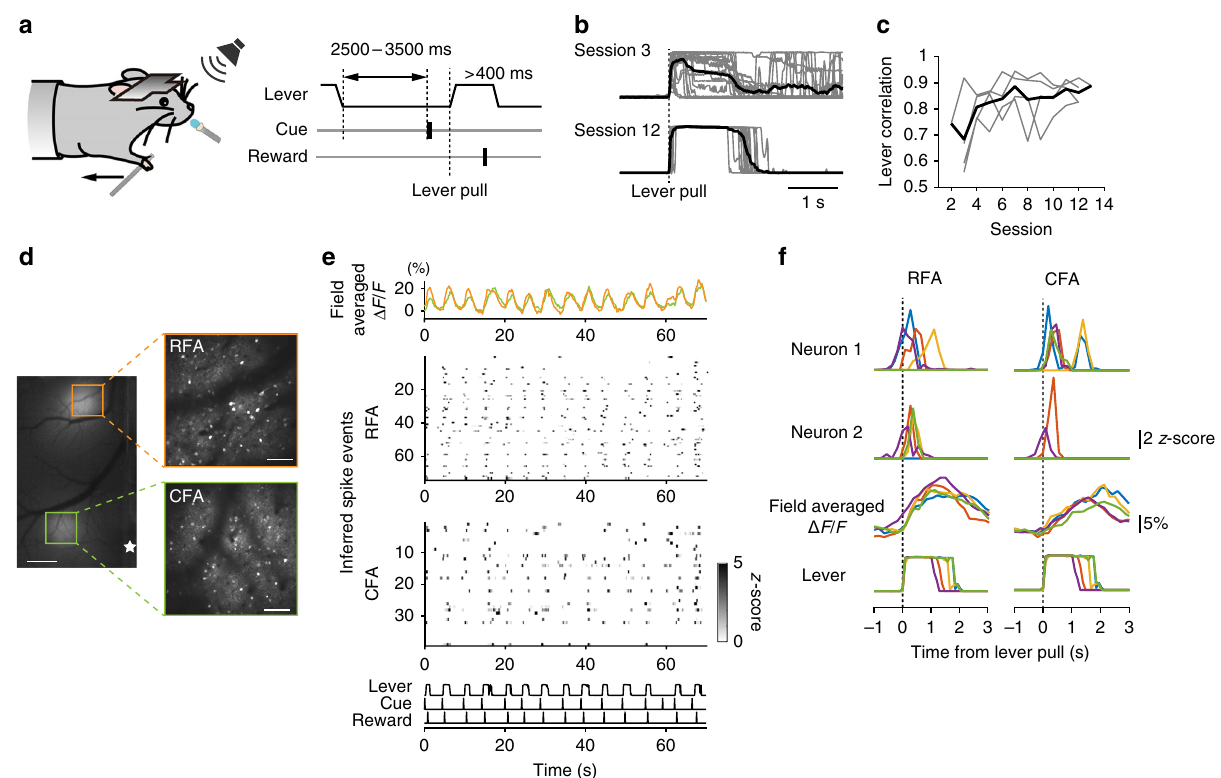
Fig. 7 Dual- fi eld imaging of the RFA and CFA during performance of a forelimb-movement task. a Schema of the sound-cued lever-pull task. To obtain a drop of water, the mouse needed to use its right forelimb to pull the lever 5 mm for a duration of 400 ms after presentation of a tone. b Example lever trajectories from sessions 3 and 12. Lever trajectories were aligned to the lever-pull onset. The fi rst 20 trials of each session are shown. Gray lines indicate individual trials and black lines are the means. c Improvement in lever correlation during the task sessions. The sessions in which the mice performed a simpler task to associate the cue signal and licking (session 1 for one mouse and sessions 1 and 2 for three mice) were not plotted. d Left, an epi fl uorescence image of GCaMP6s-expressing neocortex. Orange (RFA) and green (CFA) squares indicate imaging fi elds of the dual- fi eld two-photon imaging. The white star indicates the bregma. Scale bar, 500 µ m. Right, averaged two-photon images of layer 2/3 neuronal somata in the RFA and CFA. Scale bar, 100 µ m. e Representative neuronal activity of RFA and CFA somata during performance of the forelimb-movement task. Averaged fl uorescence change of the whole imaging fi eld (top; fi eld-averaged Δ F/F ), z -scored inferred spike events of neurons (middle), and lever trajectory, cue, and reward timings (bottom). f Traces of inferred spike events from four neurons numbered in e , fi eld-averaged Δ F/F , and lever trajectory from fi ve representative successful lever-pull trials. Each color (blue, red, yellow, green, and purple) indicates traces from the same